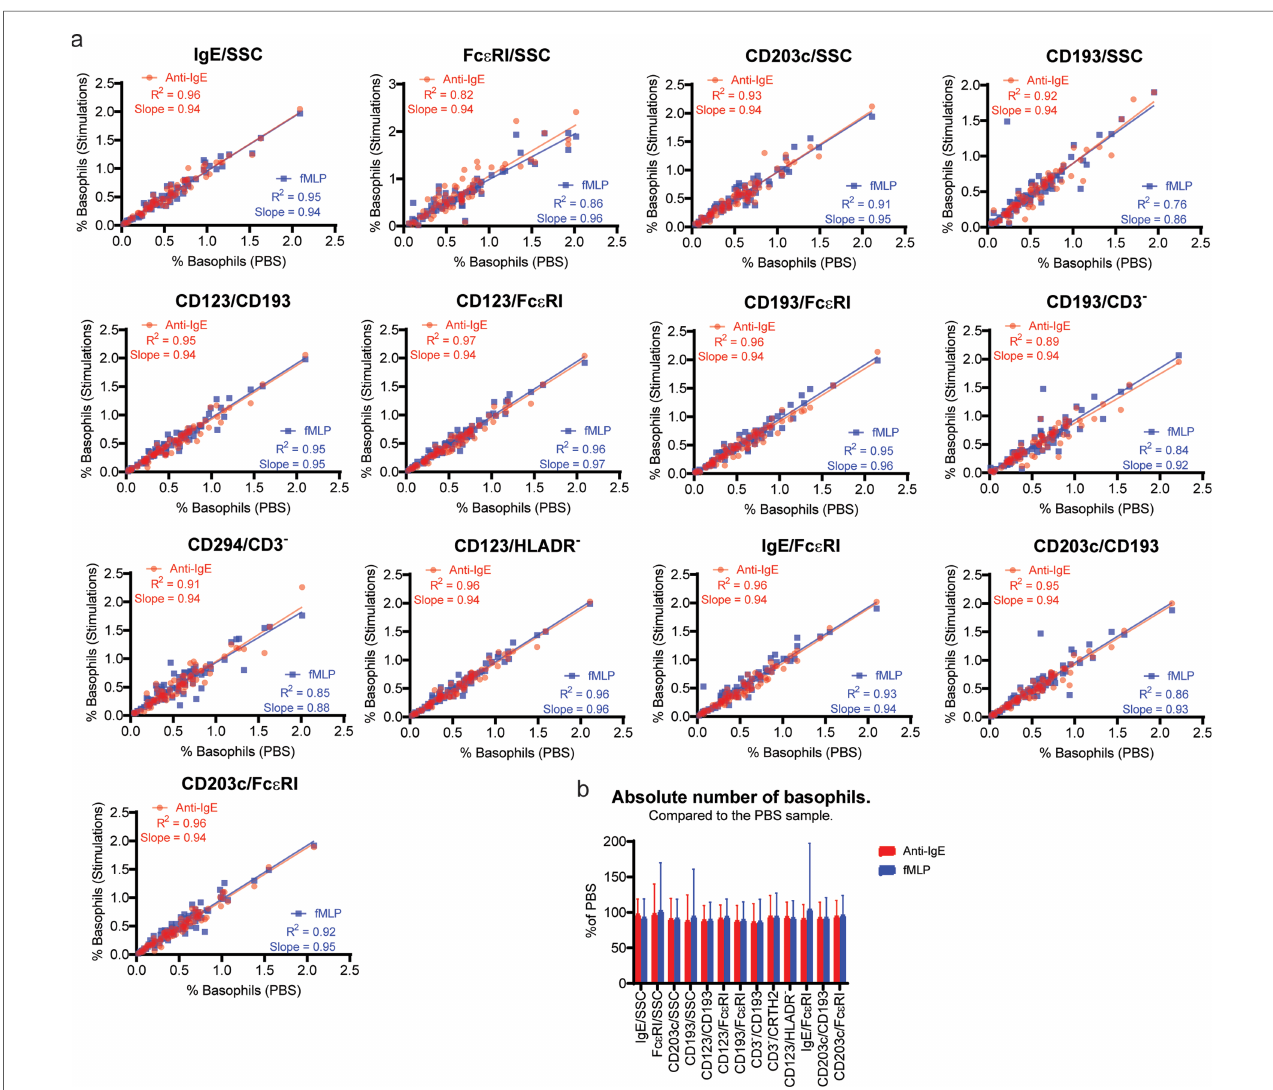
FIGURE 3 Identi fi cation of activated basophils. Whole blood was stimulated with either Anti-IgE FITC or fMLP for 20 min before staining for basophil identi fi cation together with the unstimulated control sample (PBS). ( A ) Linear regression analysis shows the comparison between the PBS and Anti-IgE FITC or fMLP for each of the 13 identi fi cation methods. The basophils number shown is as % of WBC. ( B ) The absolute number of basophils collected in the Anti-IgE and fMLP stimulated sample using the different gating strategies are shown as percentages of the absolute number of basophils in the PBS